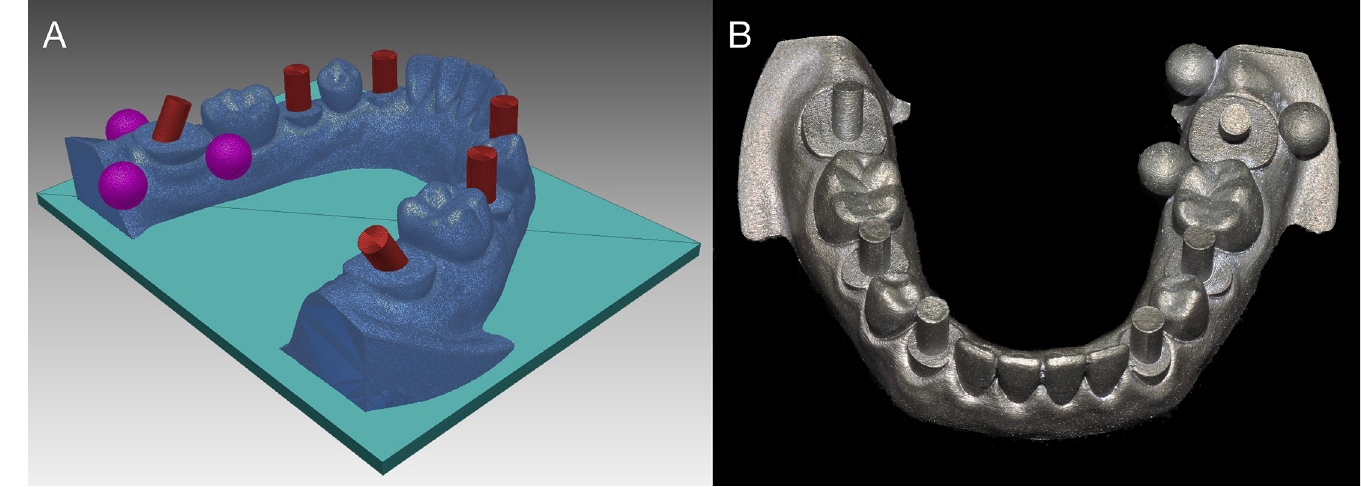
Fig 1. Experimental model. (A) Cylinders and reference spheres digitally formed using a reverse engineering software. (B) 3D printed Co-Cr master model.